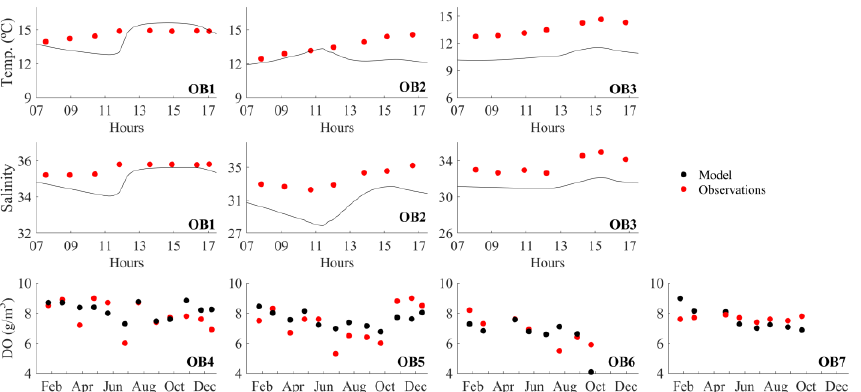
Figure 4. Comparison between model results and observations of sea surface elevation for OB1, OB2, and OB3 stations and current velocity for T1, T2, and T3 transects located at Ó bidos Lagoon.